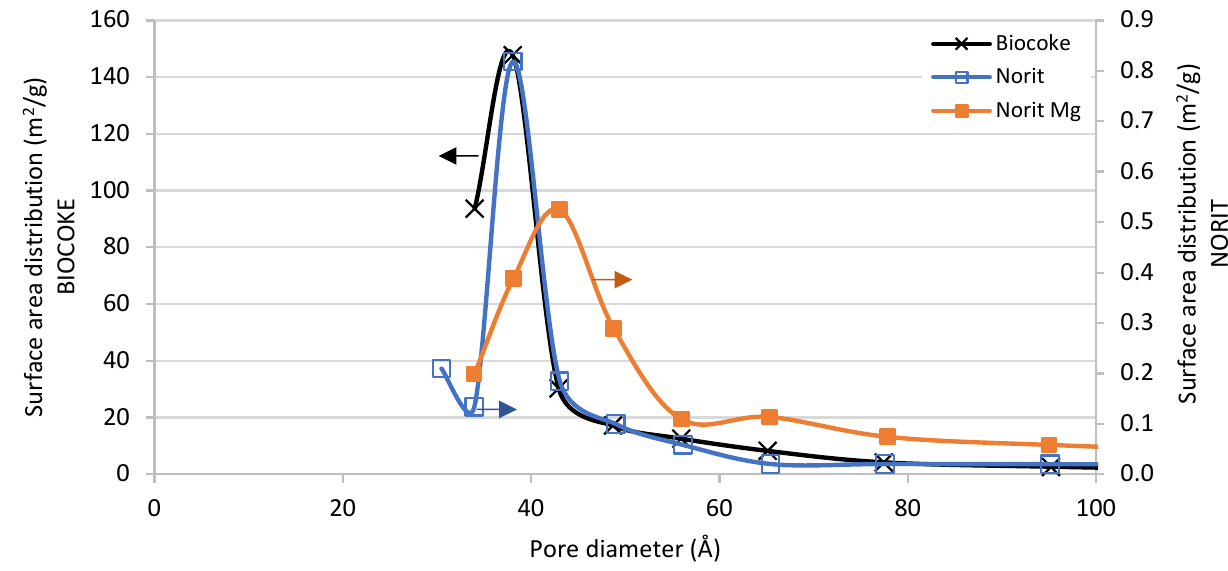
Pore diameter (Å) Figure 6. Comparison of the surface area distribution for biocoke (left axis), commercial activated carbon Norit (right axis) and Mg modified Norit (right axis). Obtained from the N 2 adsorption– desorption isotherm data. (BJH method desorption surface area).